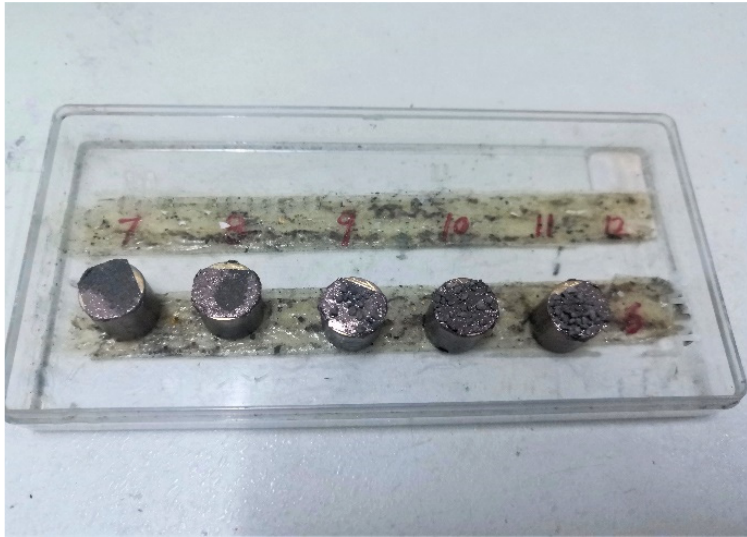
Figure 4. SEM scan